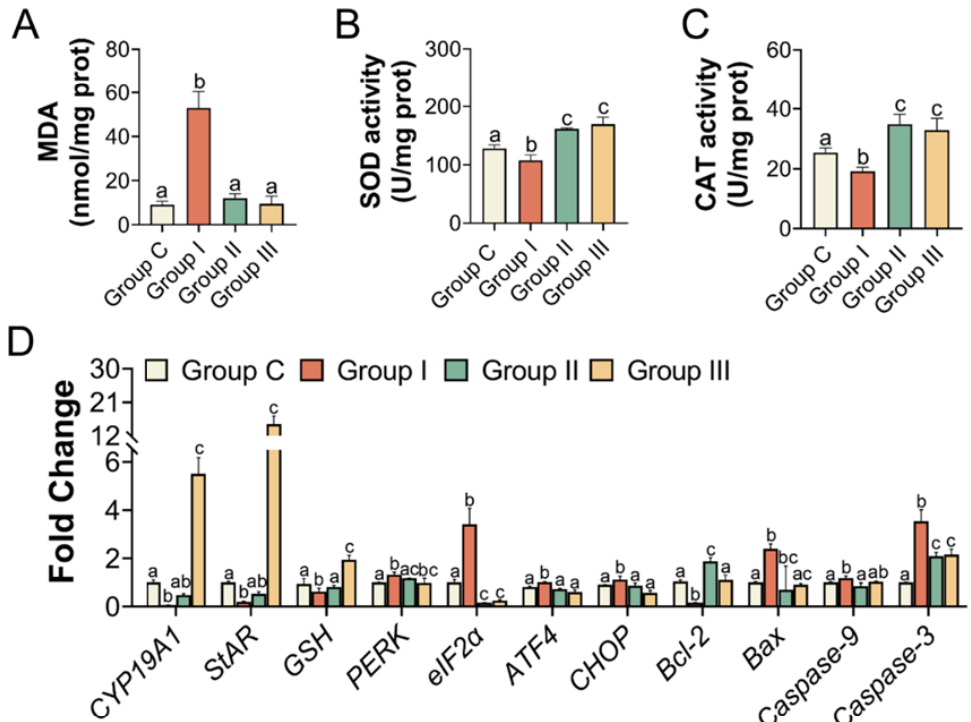
Figure 6. Oxidative stress indicators and relative expression of genes in the ovary. ( A ) The concen- tration of MDA, the antioxidant activity of SOD, and CAT ( B , C ), n = 5 per group. ( D ) The relative mRNA levels of oxidative stress, ER stress, apoptosis, and hormones in the ovary, n = 3 per group. Different letters indicate significance.